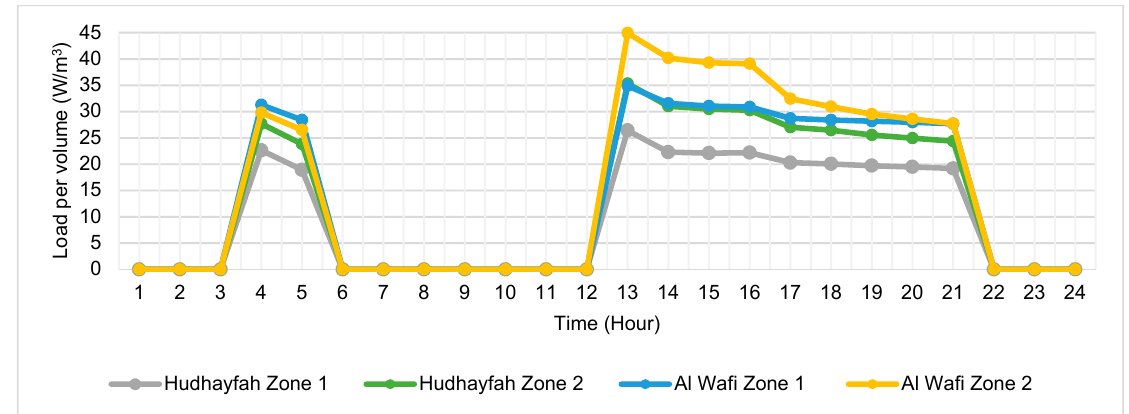
Figure 20. Comparison between Hudhayfah and Al Wafi mosques’ cooling loads per volume across Zones 1 and 2 for both mosques during day 179 (Summer).